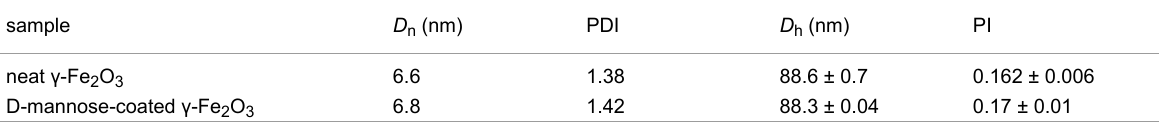
Table 1: Properties of superparamagnetic nanoparticles. a sample